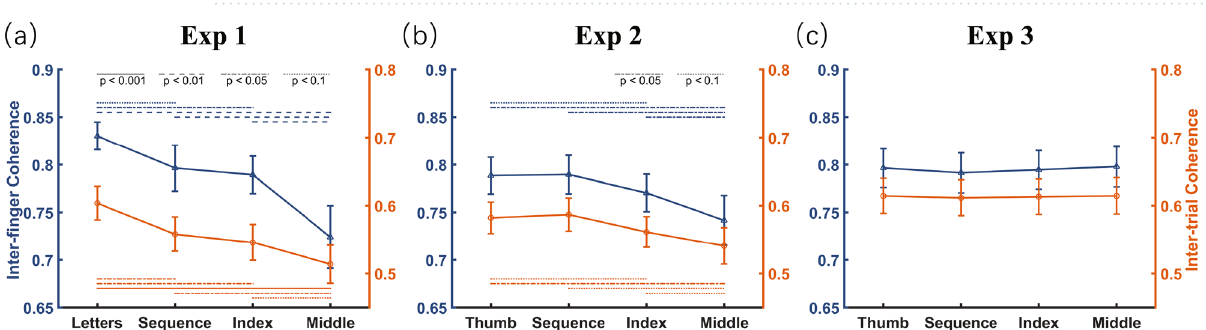
Figure 4. Temporal coherence of finger trajectories varying as a function of attentional focus. Each panel indicates results with respect to inter-finger (shown in blue) and inter-trial (shown in orange) temporal coherence, with x-axis labels indicating four attention conditions with different attentional foci. The error bar indicates one